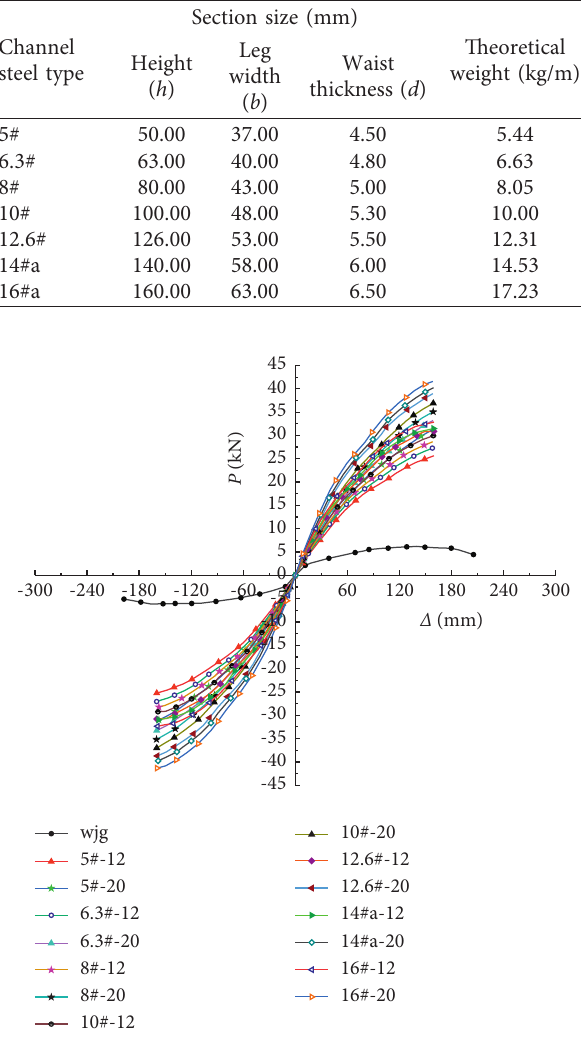
Table 6: Specifications of channel steel of different types.